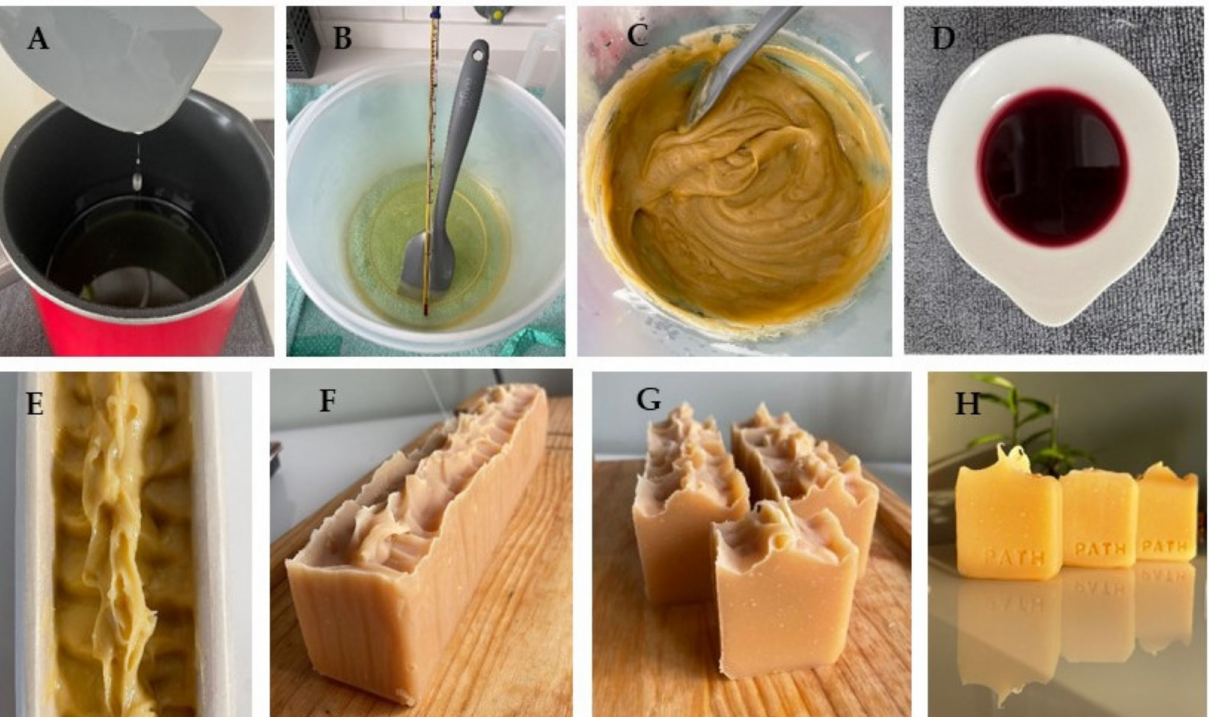
Figure 4. Juçara natural soap production. ( A ) Oil and butter heating; ( B ) melted butter and oil mixture; ( C ) soap mass before additives; ( D ) juçara extract (42.6% of 1,2-propanediol in 1:50 g/mL of juçara dried pulp); ( E ) parchment paper-lined molds filled with soap mass; ( F ) loaf of soap after 24 h; ( G ) soap bars; and ( H ) soap bars after